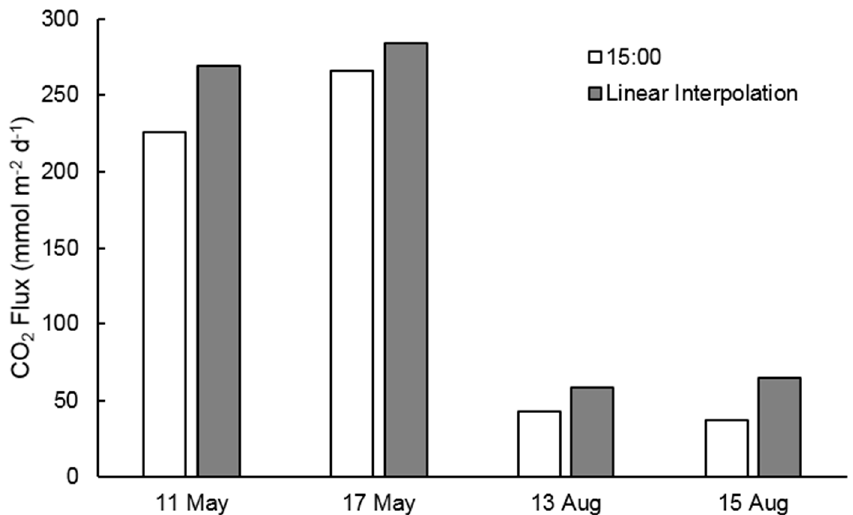
Figure 5. Comparison of daily outgassing calculations. “15:00” data represents extrapolating CO 2 flux rates at 15:00 CST over the 24-h period. “Linear Interpolation” data represents daily flux calculated by linear interpolation between 3-h intervals.